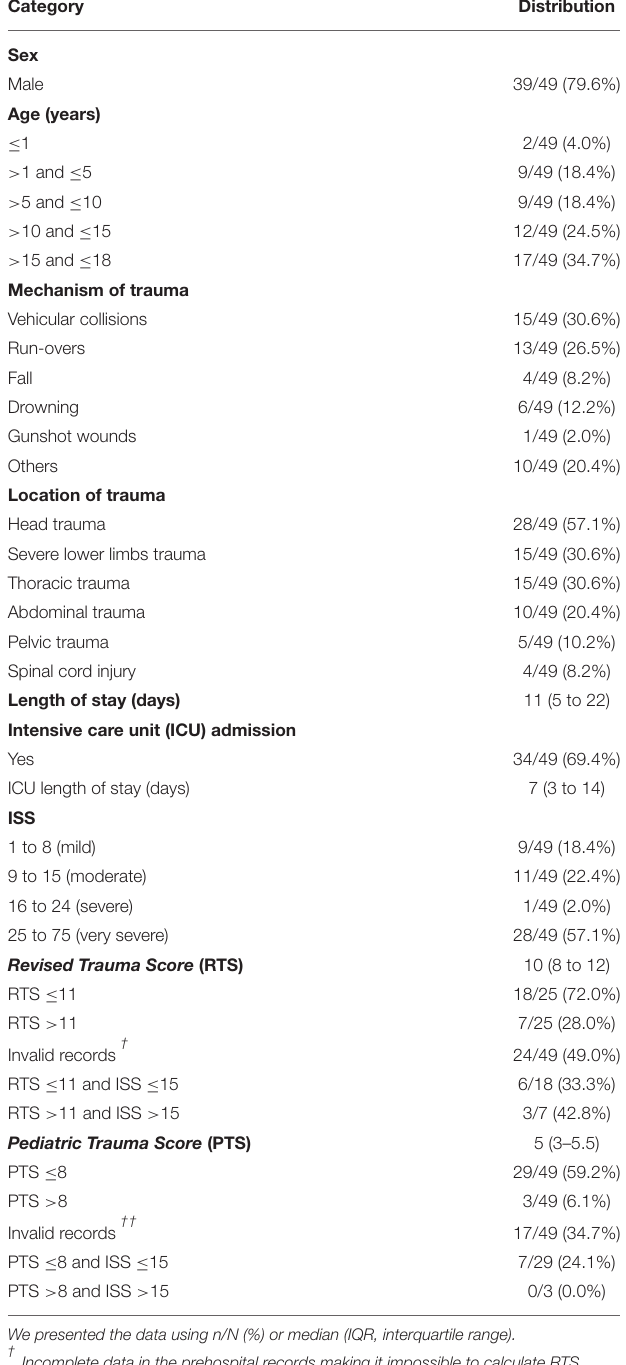
TABLE 1 | Description of the demographics, mechanism and location of the trauma, secondary outcomes, and severity according to the Injury Severity Score (ISS) and prehospital triage